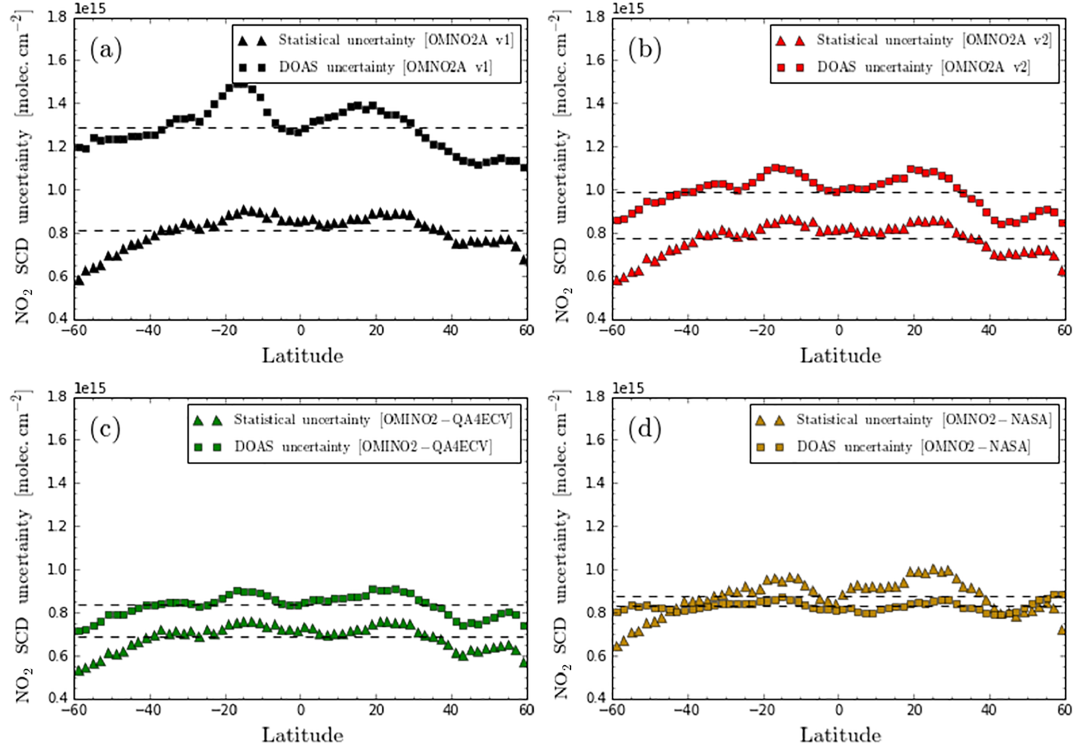
Figure 3. Average statistical (triangles) and DOAS (squares) OMI NO 2 SCD uncertainty of all boxes within 2 ◦ wide latitudinal bins for the OMNO2A v1 ( a , black), OMNO2A v2 ( b , red), OMINO2–QA4ECV ( c , green), and OMNO2–NASA ( d , yellow) slant columns for the Pacific orbit from day 1 of January, April, July, and October 2005–2015. The standard deviation of the slant columns in a box stands for the statistical uncertainty, while the box-mean value of the DOAS fit uncertainties stands for the DOAS uncertainty. We require at least 10 pixels within a box for a robust application of statistical analysis. The dashed line represents the average slant column uncertainty over all latitudes. No cloud screening has been